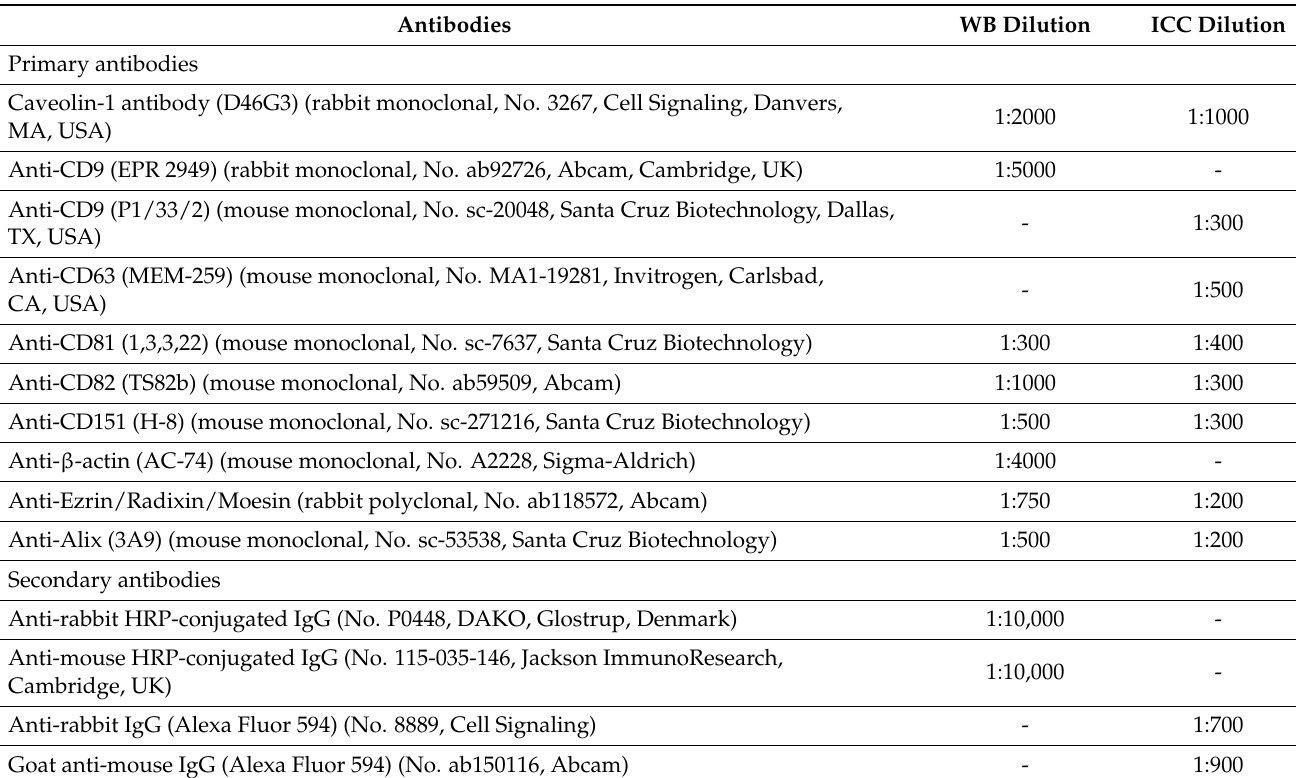
Table 2. List of antibodies used for WB and ICC/IF. Antibodies WB Dilution ICC Dilution Primary